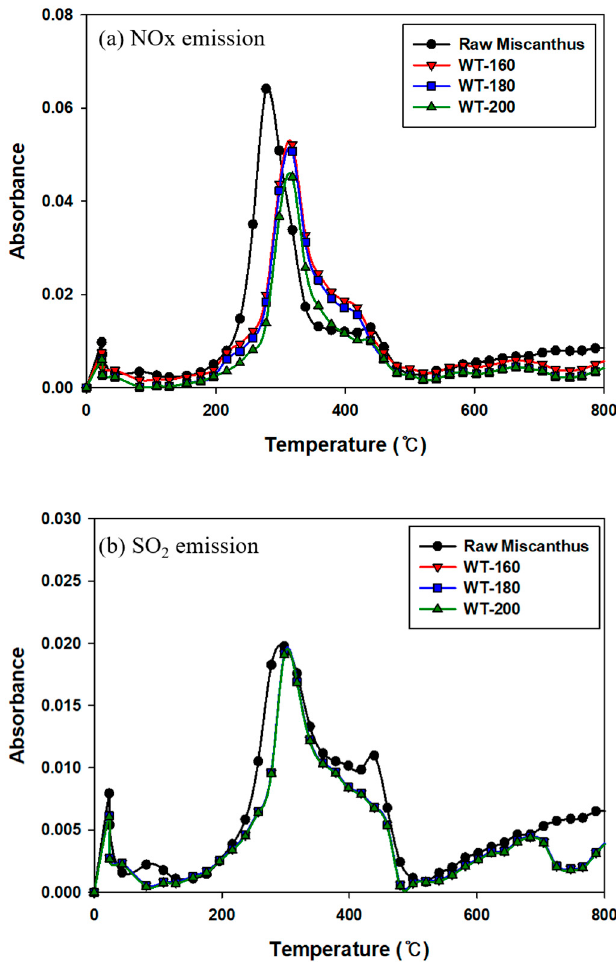
Figure 5. NOx and SO 2 emissions of Raw Miscanthus (RM) and WT samples.